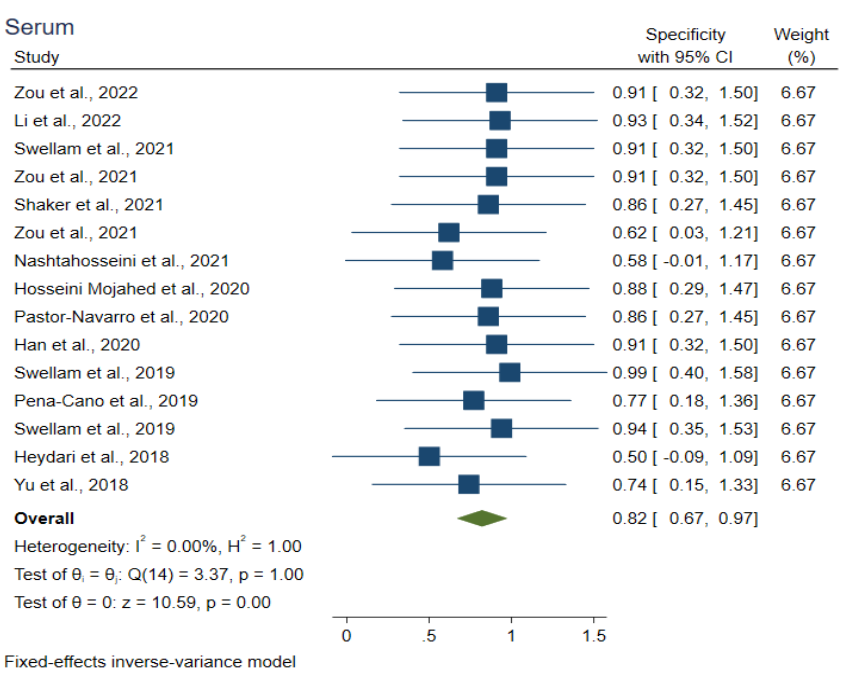
Fig. 5. Specificity of circulating microRNAs on serum models.